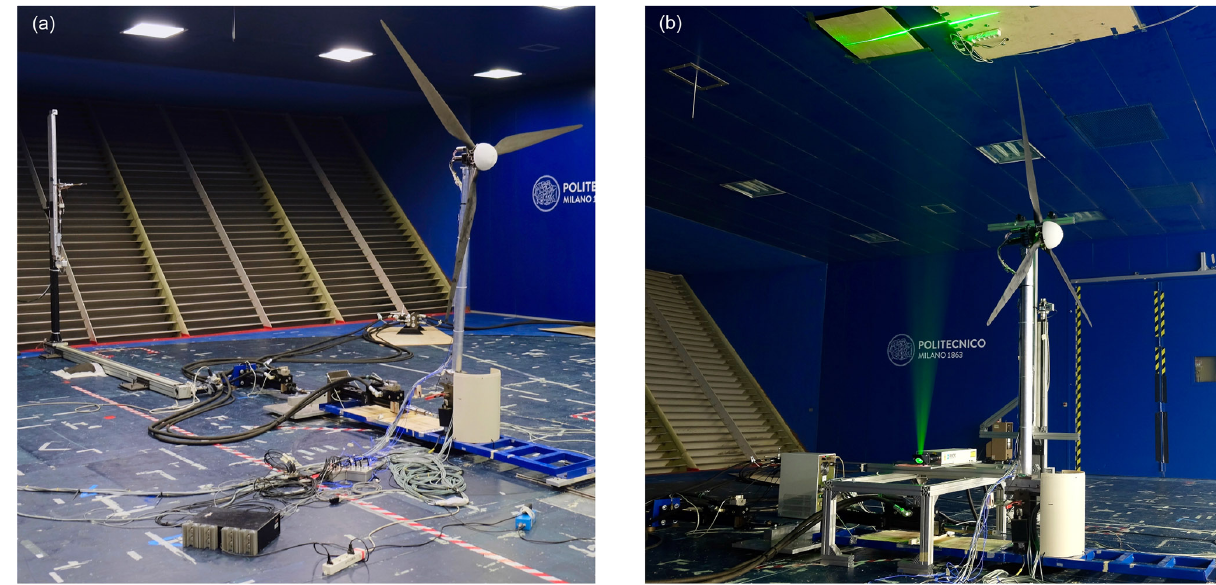
Figure 7. Test setup for along-wind (AW) hot-wire measurements (a) and PIV (b) measurements.